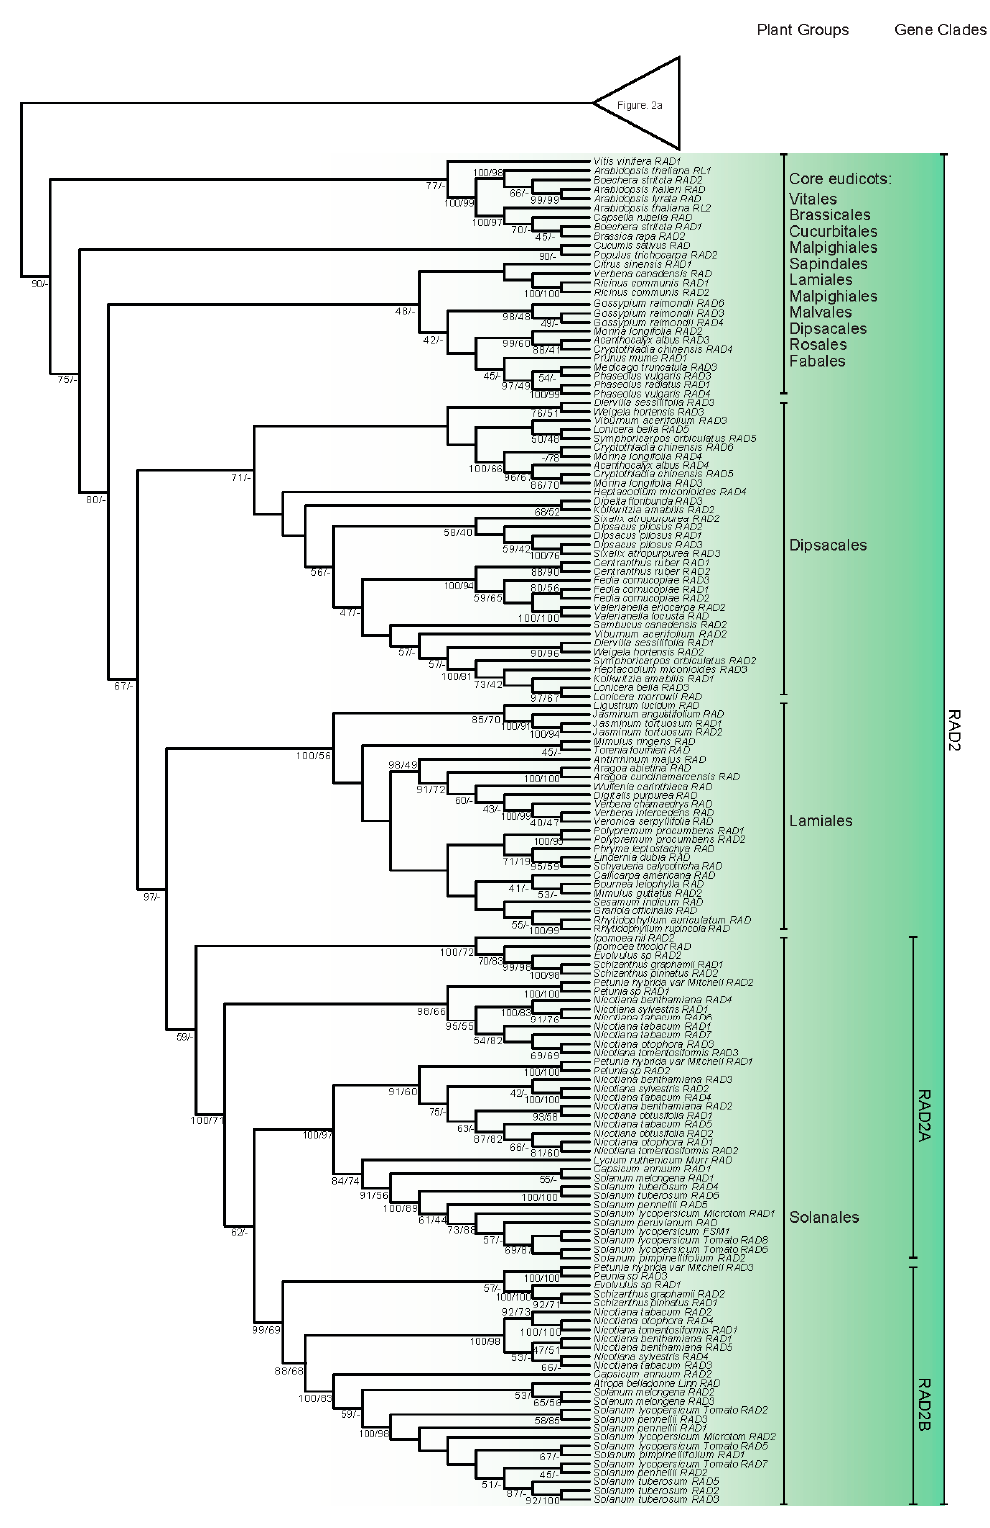
Figure 2. Phylogeny of I-box-binding/RADIALIS- like genes based on Bayesian and ML inferences. 274 CDSs of I-box-binding/RADIALIS- like genes from both monocots and dicots were analyzed. All sequences from monocots formed a monophyletic group was used to root the phylogeny. RAD2 formed a monophyletic clade. At least one gene duplication was identified in the common ancestor of Solanaceae and Convolvulaceae. RAD1 and RAD3 clades are paraphyletic. Bayesian posterior probabilities and bootstrap frequencies ≥ 40% depicted close to the branches, respectively.